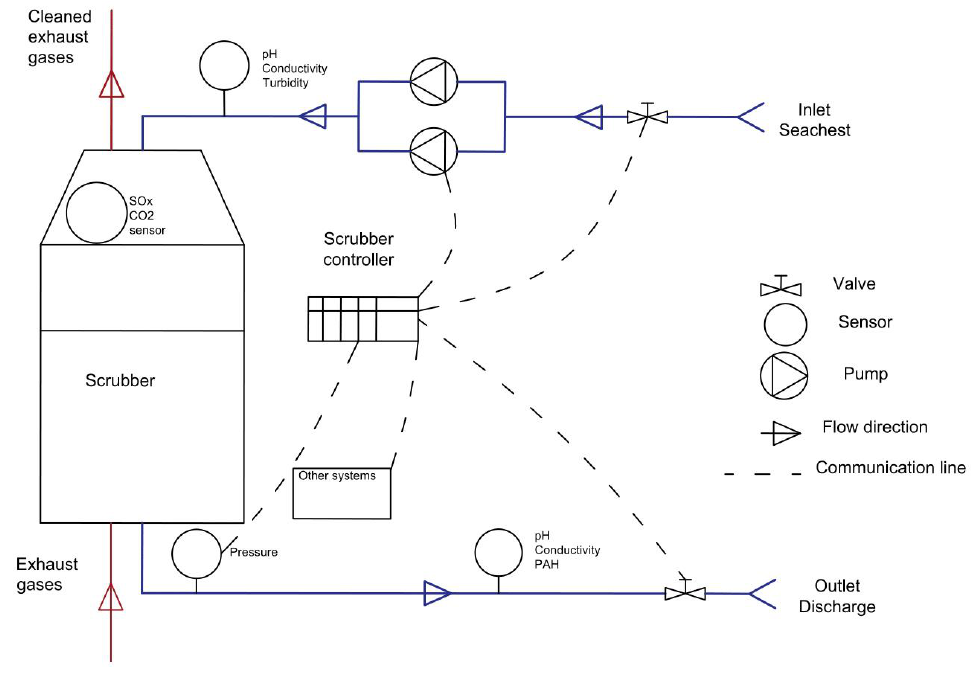
Figure 7. Investigated exhaust gas open loop scrubber system layout (based on [61]).